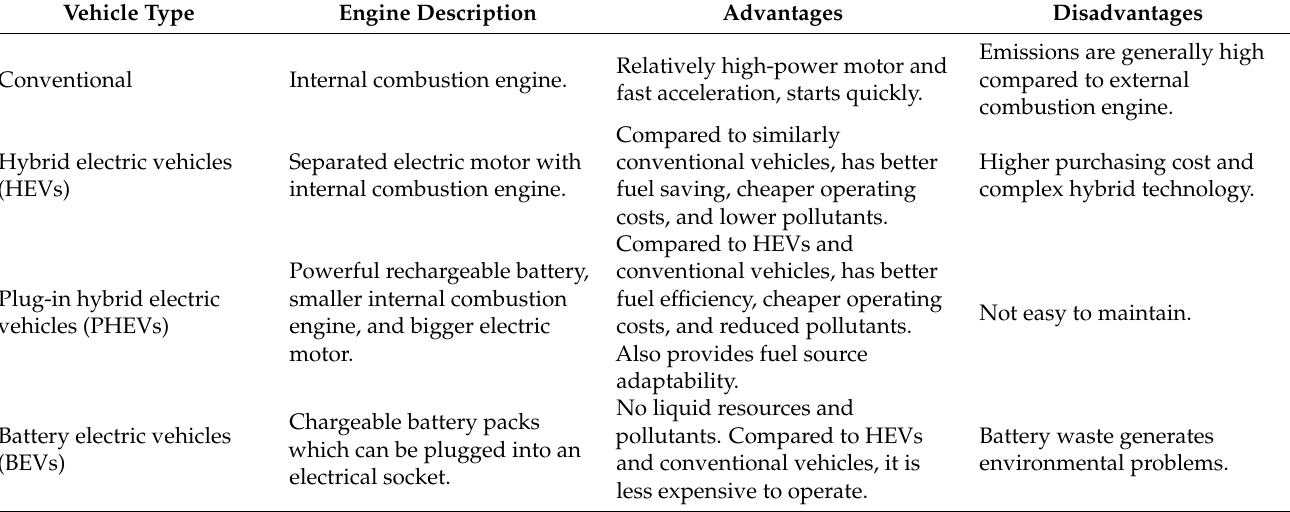
Table 1. Electric vehicle